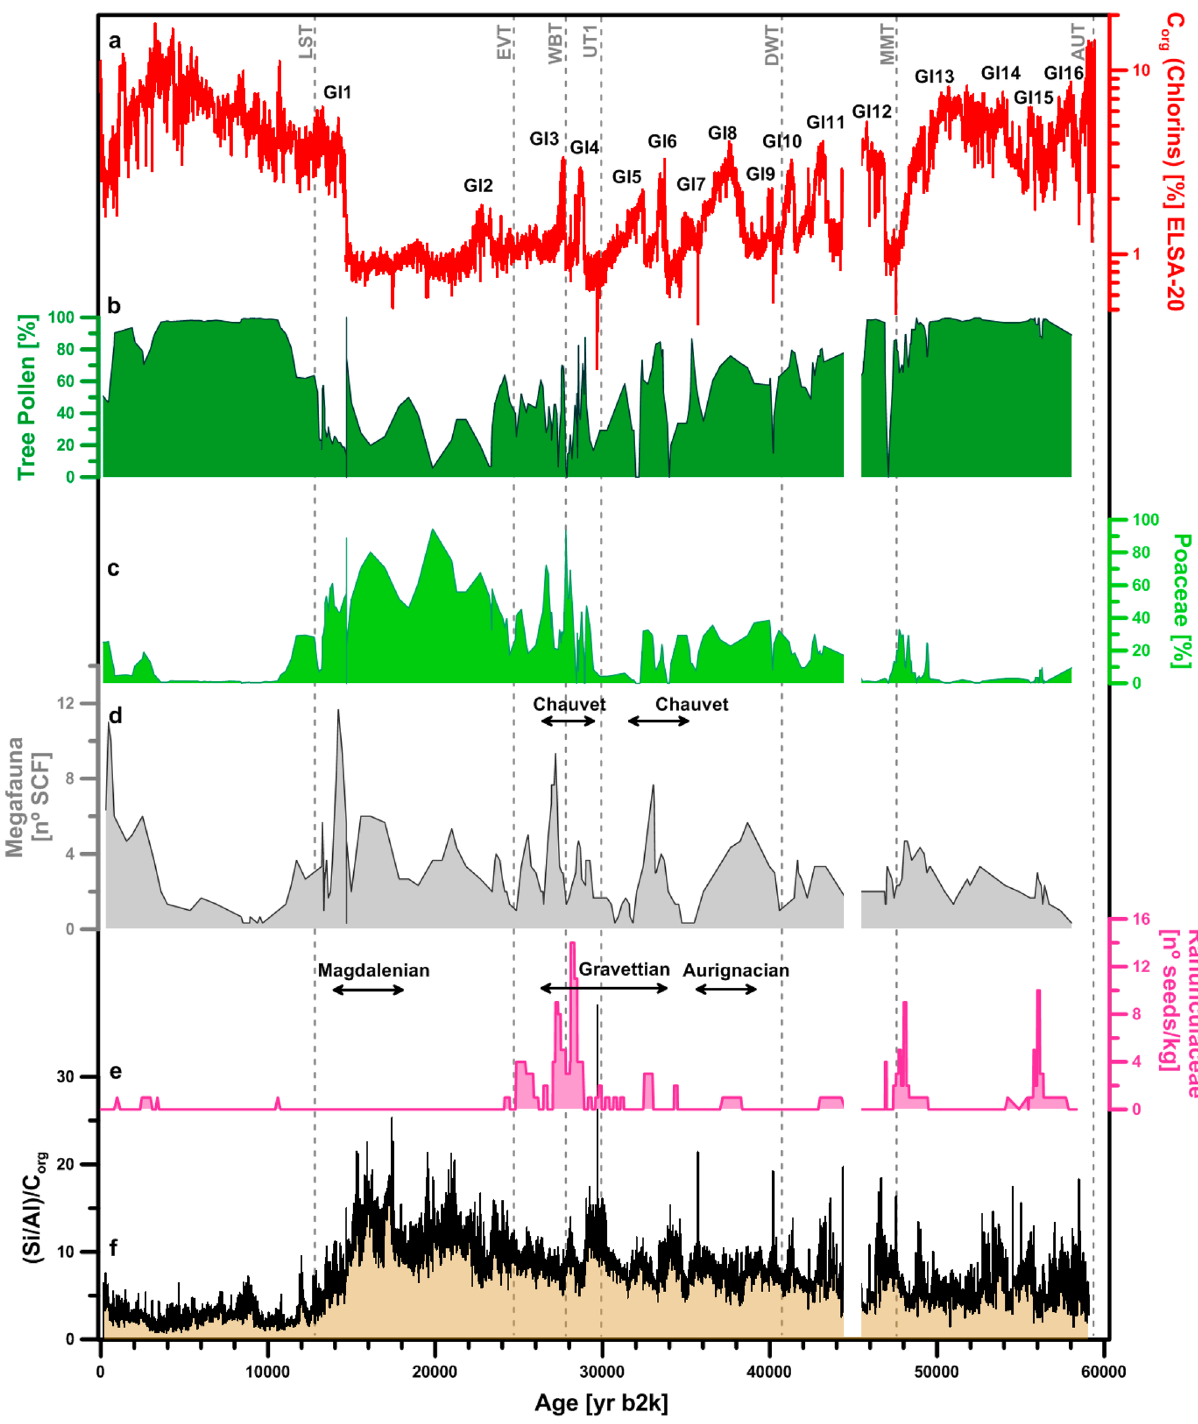
Figure 7. Synthesis of environmental change to explain the presence/absence of Megafauna during the last 60,000 years. The plots are based on all samples with countable pollen grains. All curves are smoothed, C org and Si excess with a 100 year resolution, the pollen and spores to a resolution of 200–500